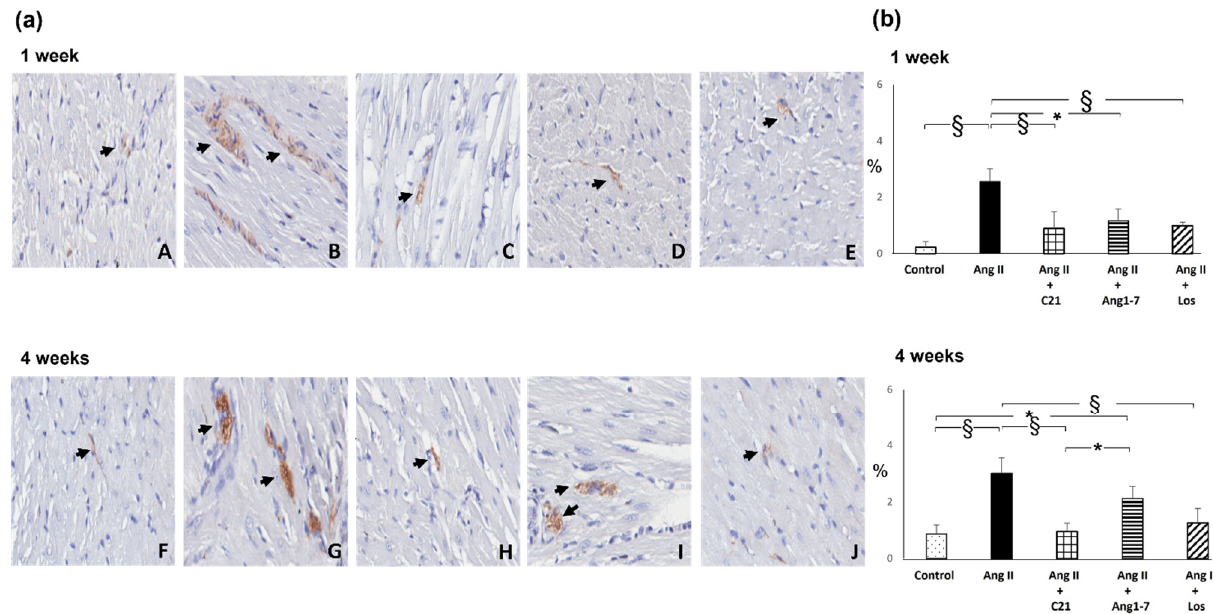
Figure 5. Myocardial tyrosine hydroxylase expression. Effects of C21 and Ang 1-7 administration on myocardial tyrosine hydroxylase expression in Ang II treated rats for 1 and 4 weeks. ( a ). Immunohistochemical identification of tyrosine hydroxylase expression at intraparenchymal nerve fiber level (brown reaction) in control (A,F), Ang II (B,G), Ang II + C21 (C,H), Ang II + Ang 1-7 (D,I) and Ang II + Los (E,J) treated rats ( × 20 magnification) at 1 and 4 weeks of treatment. ( b ). Quantification of staining of myocardial tyrosine hydroxylase expression in the different groups of rats. Data are means ± SEM. *: p < 0.05. §: p < 0.01.